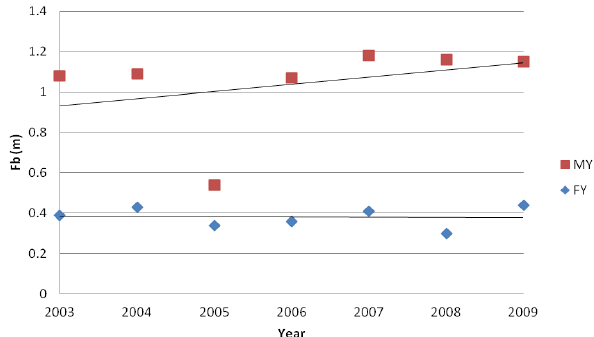
Figure 6. Mean freeboard for multiyear (MY) and firstyear (FY) sea ice in McMurdo Sound.